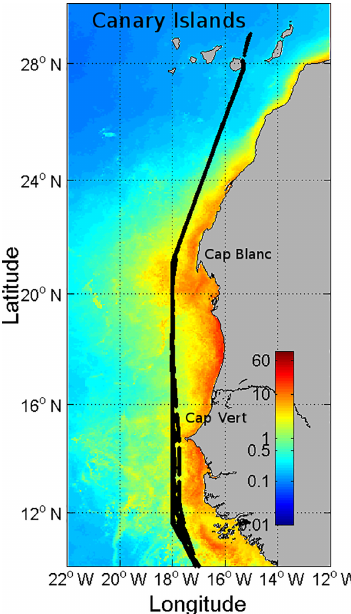
Figure 1. Ship track (black line) in the area from 28 ◦ N (Gran Ca- naria, the Canary Islands) to 10 ◦ N. The locations of Cap Blanc and Cap Vert are indicated. Monthly OceanColor Web